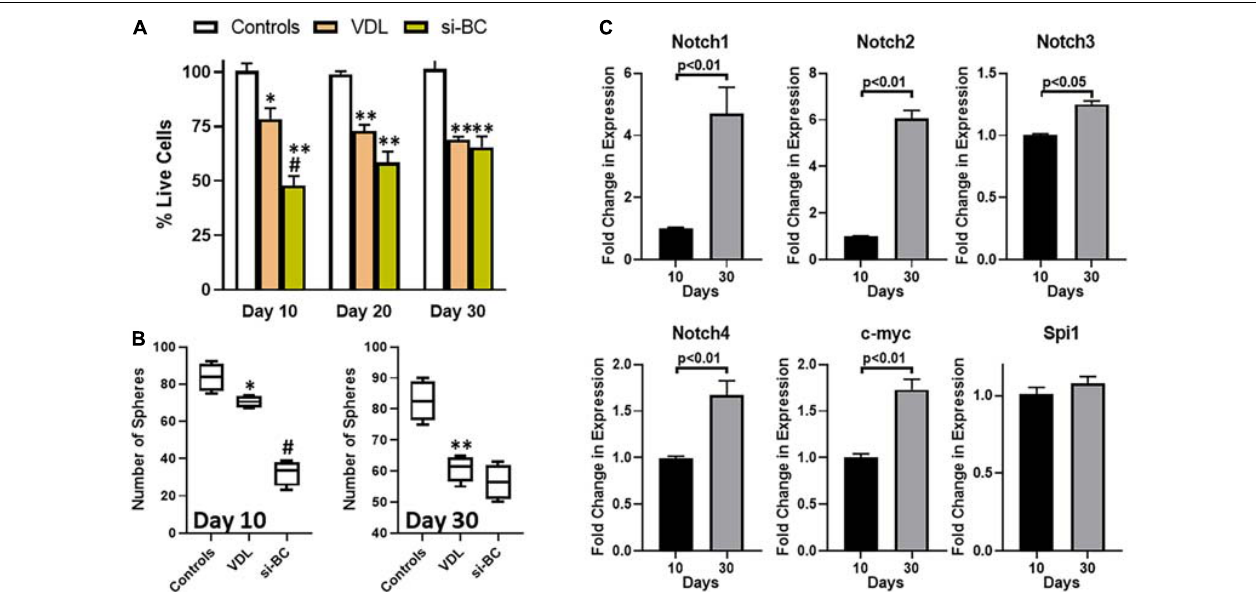
FIGURE 3 | Acquired drug resistance model and alternate signaling. (A) Flow sorted β -catenin-positive were subjected to VDL treatment, as described in section “Materials and Methods,” in the presence and absence of si-RNA specific for β -catenin. Live cells were estimated at days 10, 20, and 30, by trypan blue exclusion method. (B) Flow sorted β -catenin-positive cells were also allowed to grow in 3-dimensional cultures to generate tumorospheres, in the presence of VDL ± si-RNA specific for β -catenin. Bars represent the number of tumorospheres. (C) Gene expression levels of Notch 1–4, c-myc and Spi1, at days 10 vs. days 30 in flow sorted β -catenin-positive cells, while being treated with VDL, were determined by quantitative RT-PCR. Expression of GAPDH was used as internal control. ∗ p < 0.05 and ∗∗ p < 0.01, compared to control, # p < 0.01, compared to